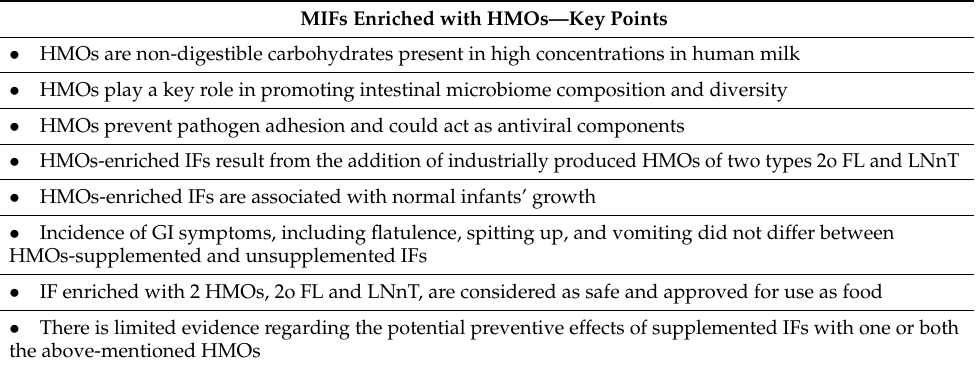
Table 4. Summary of beneficial effect of MIFs enriched with